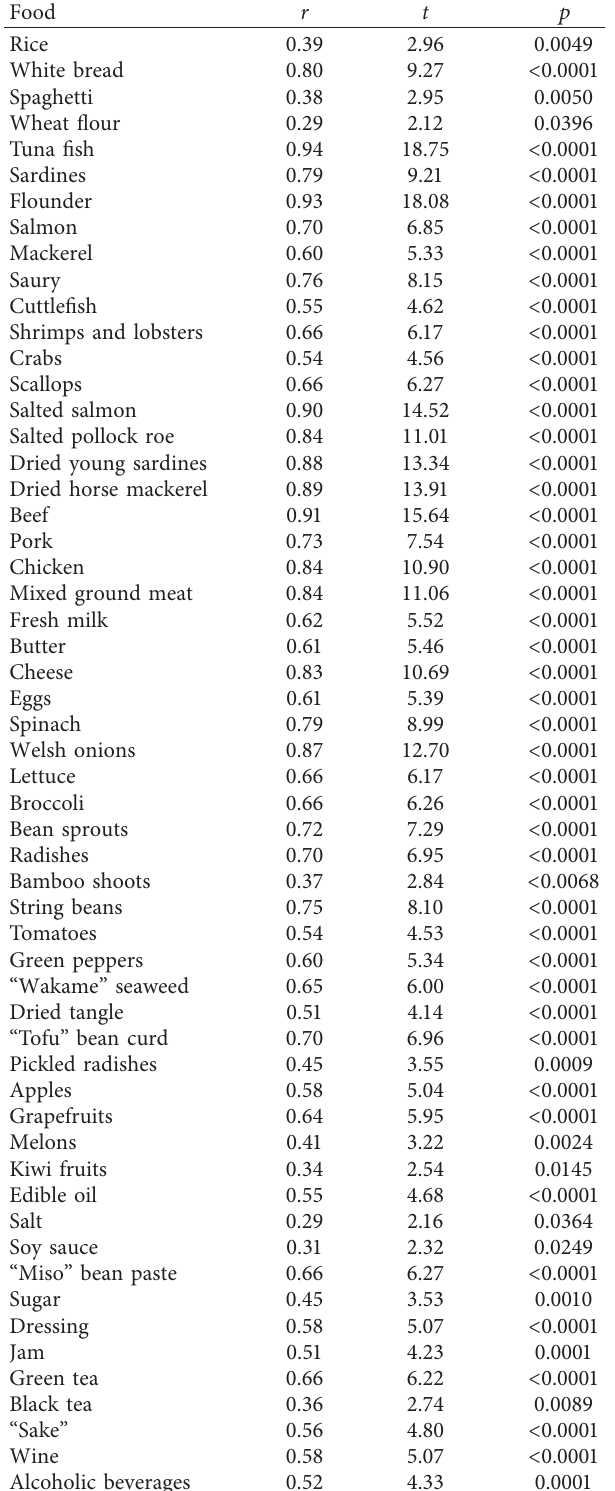
Table 2: Spearman’s correlation coefficients for the purchase rankings of each city for each of the 109 foods in 2015 and